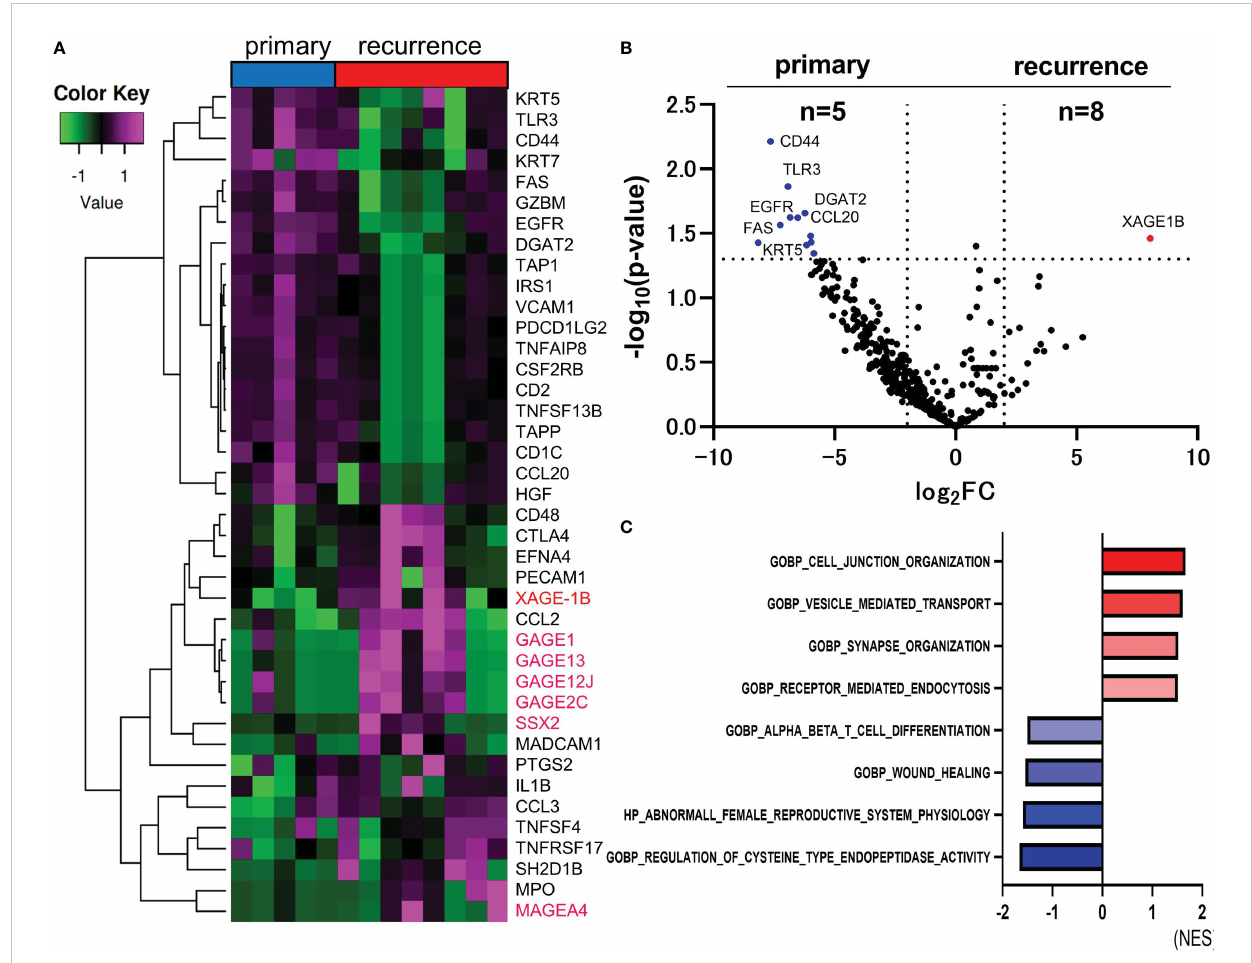
FIGURE 2 Comparison of RNA sequencing between primary and recurrent lesions in CAS. The heatmap of analyzed top 40 DEGs between primary and recurrent lesions (Total n=395 DEGs). Genes encoding CTAs are marked in magenta (A) . Volcano plot indicating upregulated genes (red) and downregulated genes (blue) in recurrent (n=8) versus primary lesions (n=5). The vertical and horizontal broken lines represent threshold of log 2 FC ( − 2 and +2) and p-value (0.05) (B) . The top four ranked gene sets with highest and smallest NES with a p-value <0.05 in GSEA compared to primary and recurrent lesions (C)